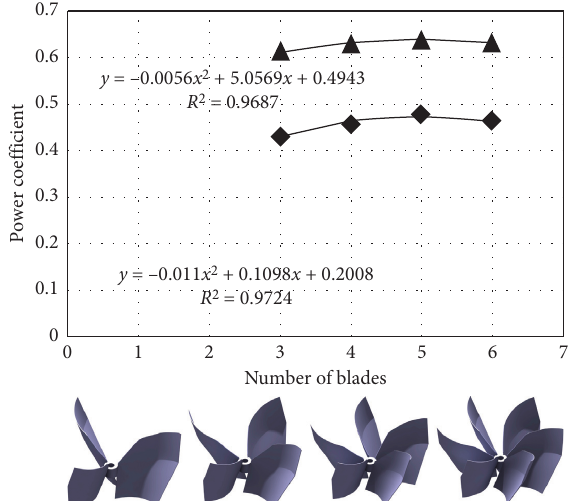
Figure 15: Set 5 data points (left to right—runners R12, R14, R15, and R16).